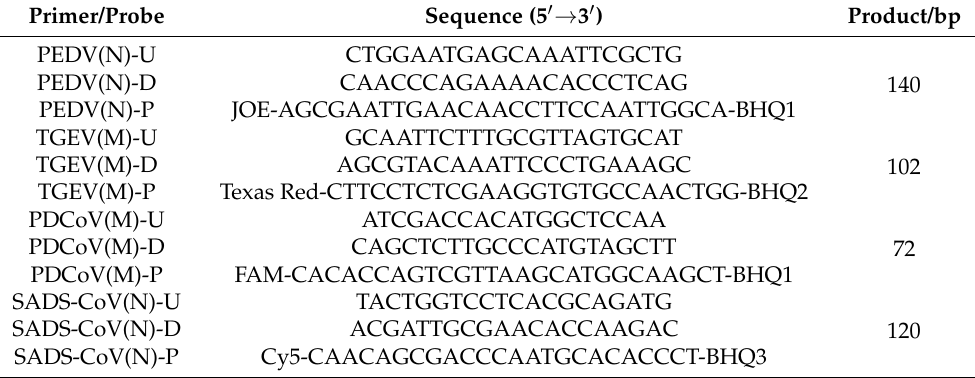
Table 1. The sequences of the primers and probes used to differentiate PEDV, TGEV, PDCoV, and